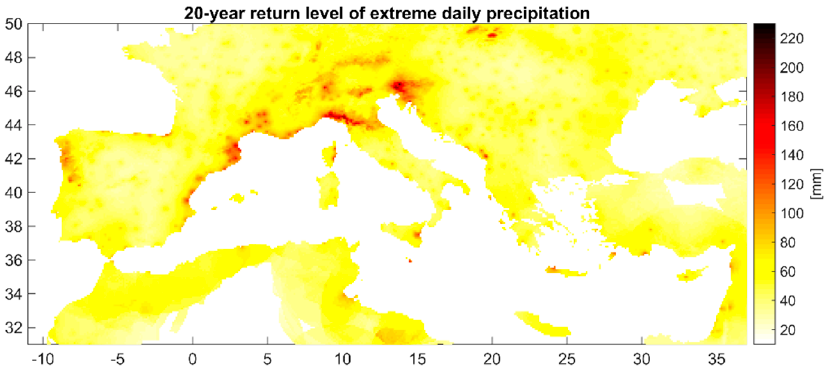
Figure 20. Twenty-year return period of extreme precipitation.